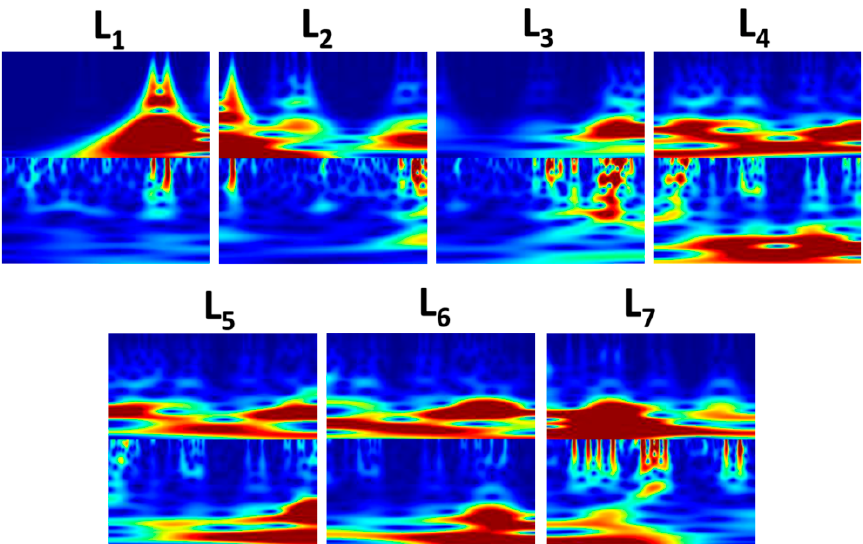
Figure 9. CNN input images with rainfall and velocity scalograms for the seven events highlighted in Figure 8. Since these images are used by a CNN, scales and color bars are not used. Table 2. Amount of scalogram images before and after data augmentation and their subdivision into datasets for training, validation, and test of the convolutional neural networks (12 computa- tion times per day).